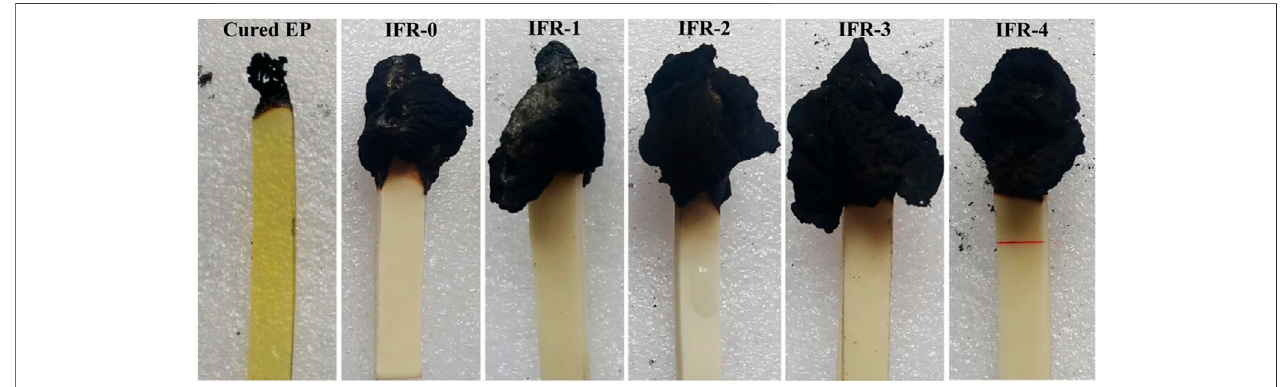
FIGURE 7 | Digital photographs of the epoxy coatings after LOI tests (Xu et al., 2018).